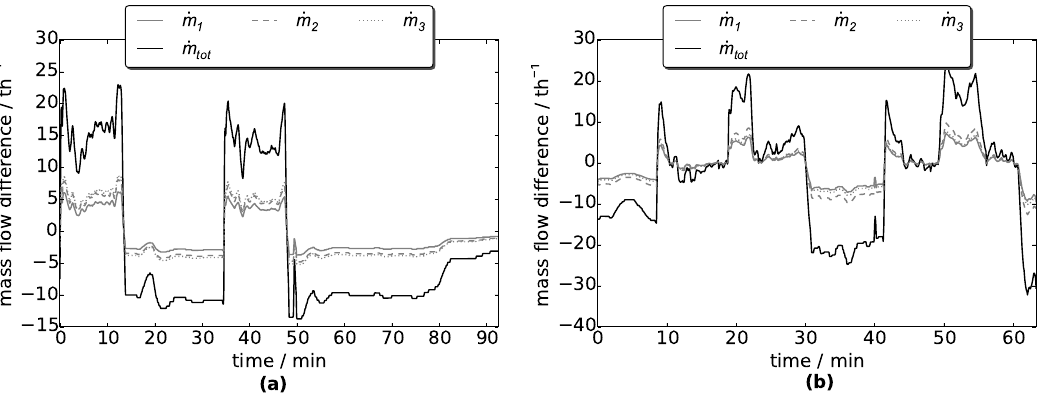
Figure 12. Mass flow difference; MD denotes the operational measurement data; 1, 2 and 3 denote the different storage vessels. ( a ) Example 1. ( b ) Example